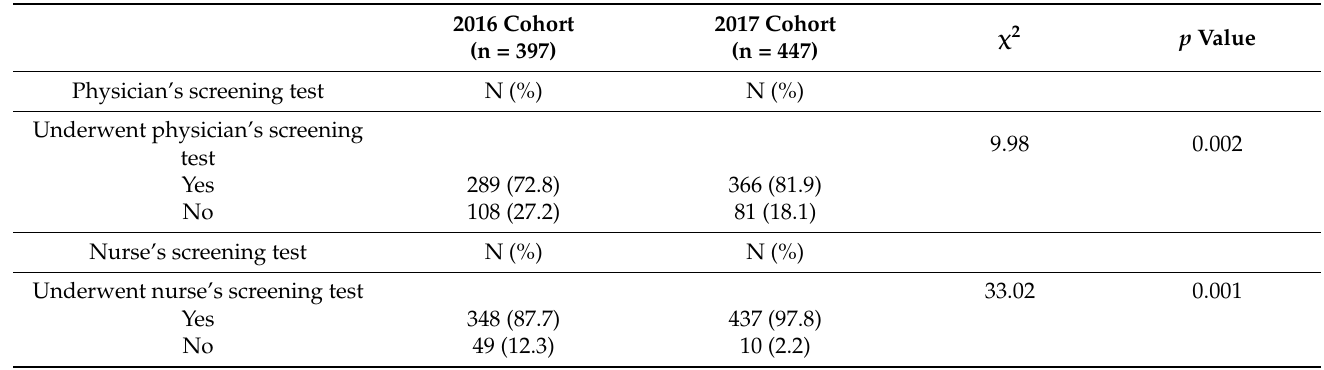
Table 1. Comparison between the 2016 and 2017 cohorts who underwent physician and nurse screening tests.